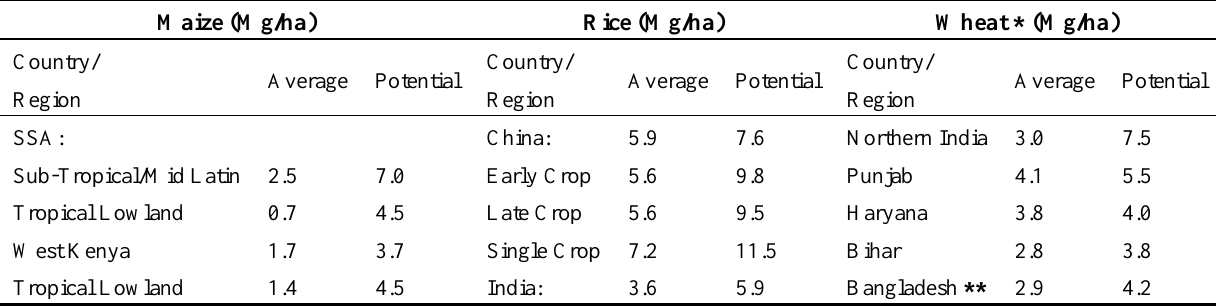
Table 6. Temporal changes in per capita land area for some regions (recalculated from [55]). Per Capita Land Area (ha/person) Region 1970 2004 Rate of Decline (ha/person/yr) Sub-Saharan Africa 0.48 0.38 0.007 Latin America 0.39 0.27 0.004 South Asia 0.27 East Asia 0.11 0.001 Table 7. Yield gap (experimental — national average) in major food crops in countries within high global hot spots of climate change (adapted from [56]). Country/ Country/ Country/ Average Potential Average Potential Average Potential Region Region Region SSA: China: 7.6 7.5 Sub-Tropical/Mid Latin 7.0 5.5 Tropical Lowland 0.7 West Kenya Tropical